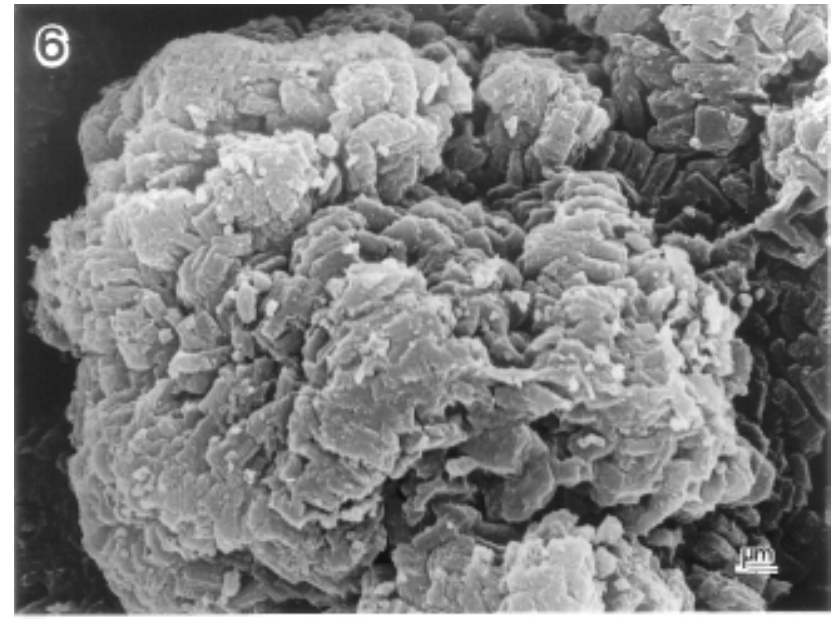
Fig. 6 – SEM of an agglomerate after being heated at 300 ◦